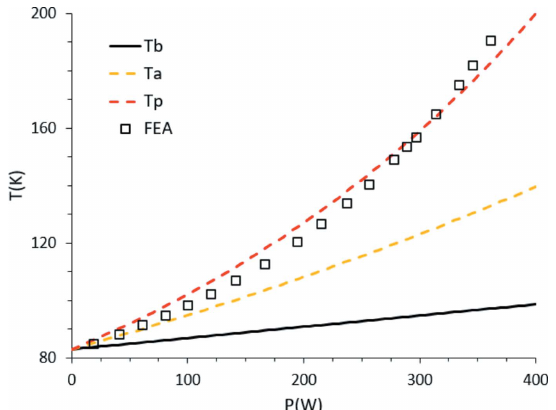
Figure 2 T a , T p calculated from equations (14 a ) and (14 b ) and compared with FEA results (Zhang et al. , 2013). We have used a = 1.7 mm.